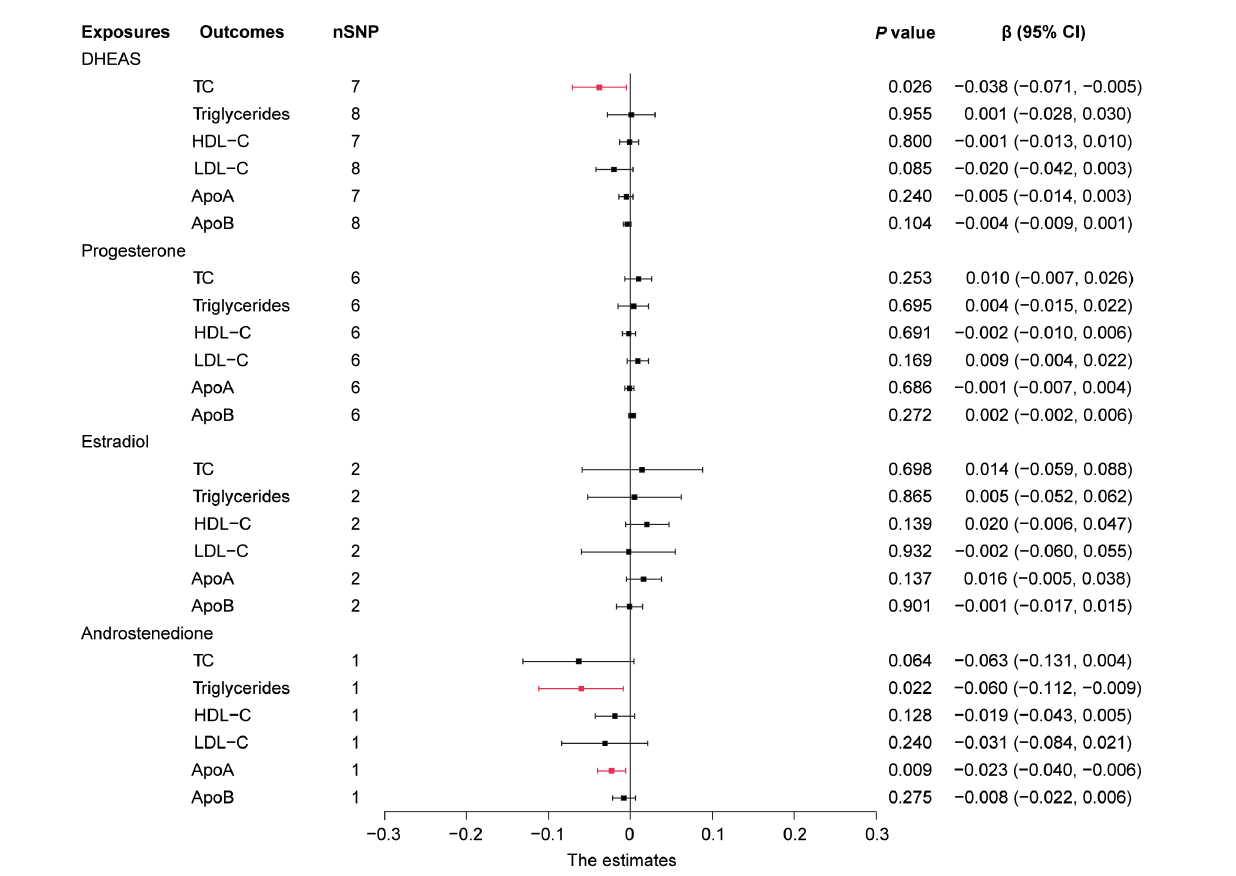
FIGURE 6 Forest plot of IVW estimates in females. DHEAS, dehydroepiandrosterone sulfate; nSNP, number of single-nucleotide polymorphisms; HDL-C, high- density lipoprotein cholesterol; LDL-C, low-density lipoprotein cholesterol; 95% CI, 95% con fi dence interval; IVW, inverse-variance weighted; TC, total